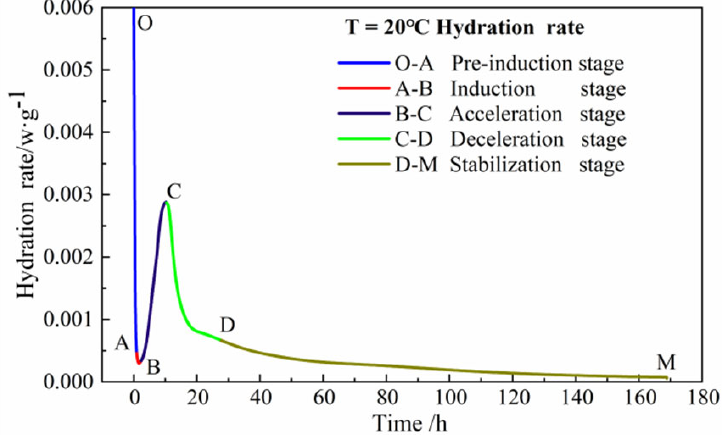
Figure 1. Cement hydration stage division.